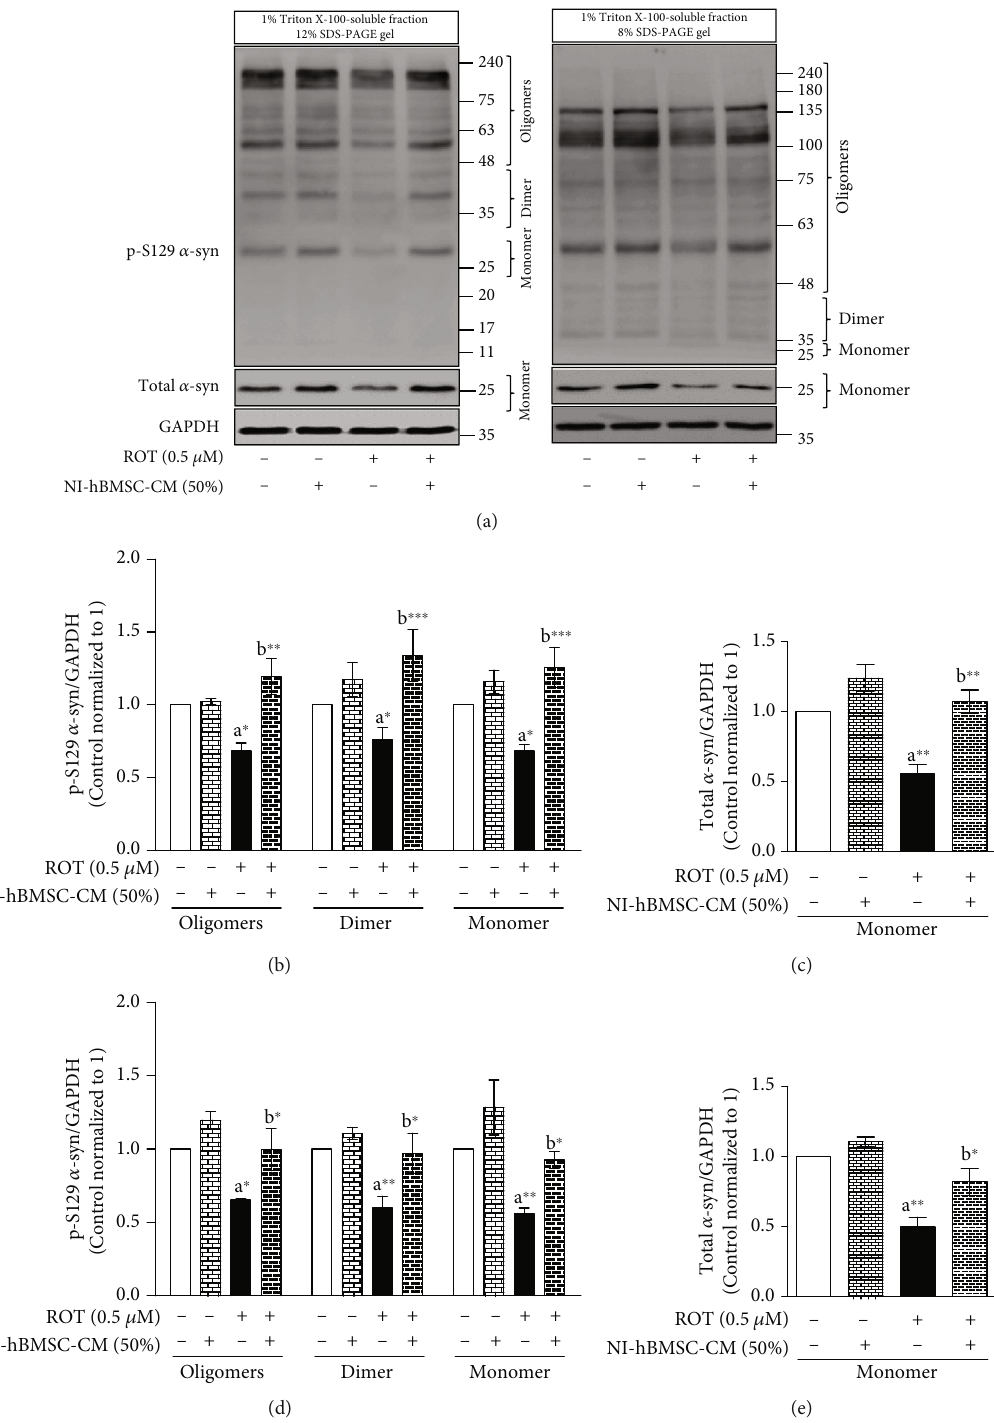
Figure 2: SH-SY5Y cells were seeded as 5 × 10 4 cells/mL of DMEM containing 1% FBS and used for experiments after overnight incubation. Cells incubated with the absence or presence of ROT (0.5 μ M) for 48h were treated with NI-hBMSC-CM (50%) during the last 24h. Cell lysates were prepared as 1% Triton X-100-soluble and Triton X-100-insoluble (2x SDS soluble) fractions. p-S129 and total α -syn were analyzed from 1% Triton X-100-soluble fractions by Western blotting using 12% and 8% SDS-PAGE gels (a). Each picture is representative of three independent experiments. Bar graphs represent fold changes in p-S129 α -syn/GAPDH (b, d) and total α - syn/GAPDH (c, e) in SDS-PAGE gels of 12% (b, c) or 8% (d, e). Data are the mean ± SEM of three independent experiments and analyzed by one-way analysis of variance (ANOVA) followed by Tukey ’ s post hoc test. Statistical signi fi cance: a compared with control; b compared with ROT; ∗ p < 0 : 01 , ∗∗ p < 0 : 05 , and ∗∗∗ p < 0 : 001